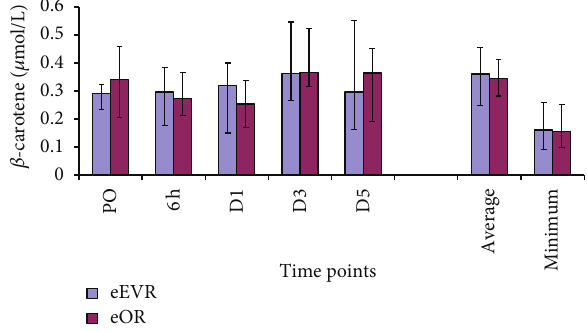
Figure 8: Serum 𝛽 -carotene levels expressed as median and IQR.